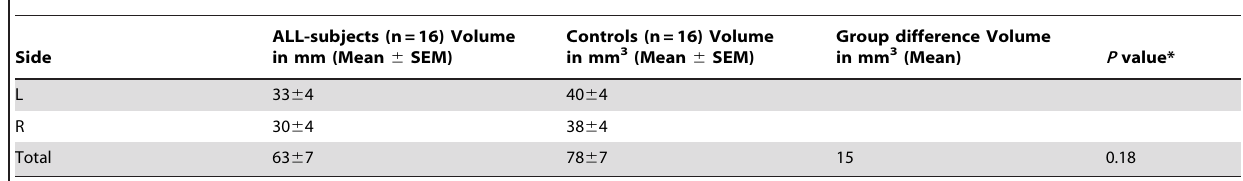
Table 4. Olfactory bulb volumes.